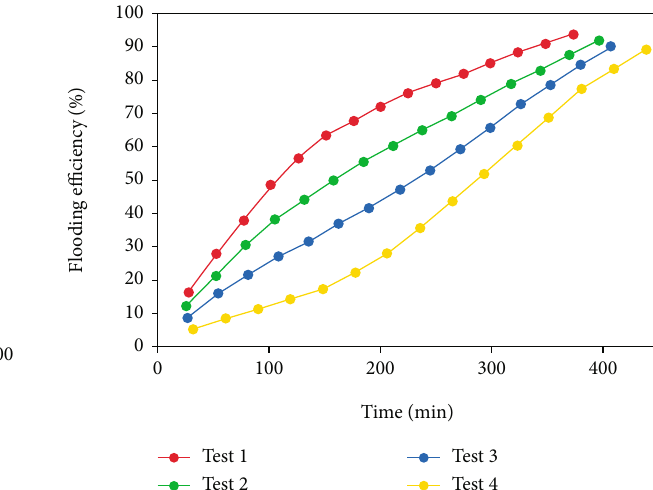
Figure 5: Air injection pressure curves.